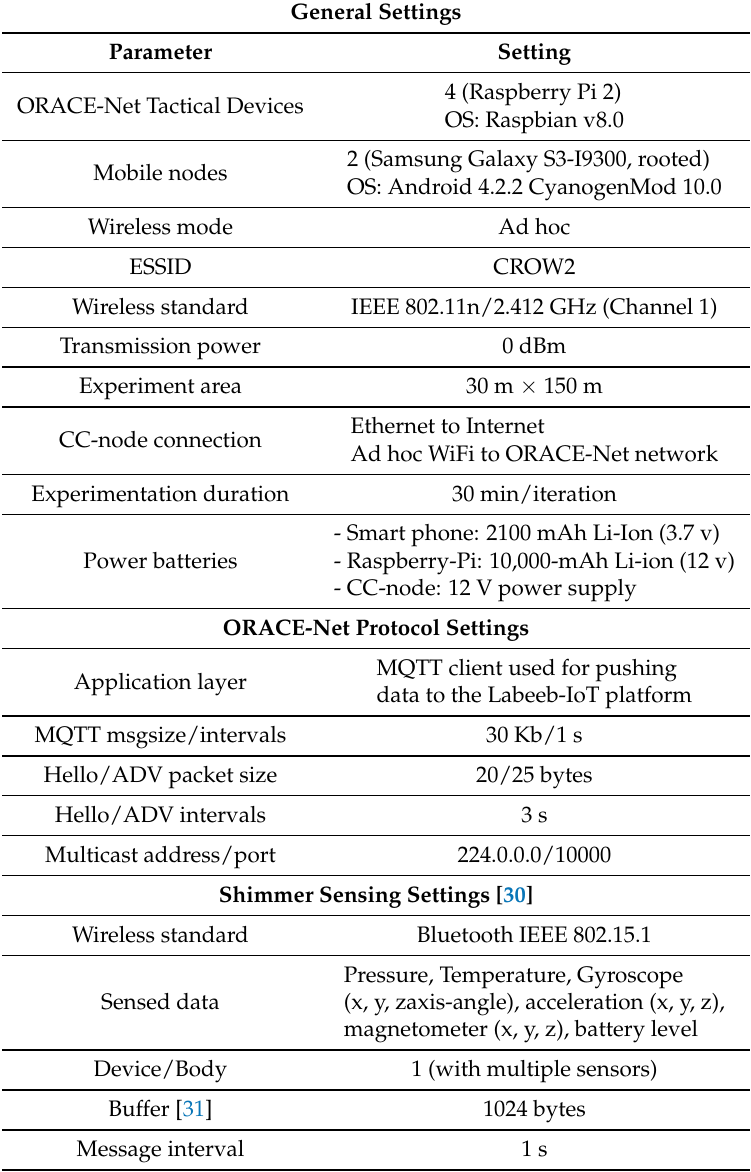
Table 2. Experimentation parameters and configuration